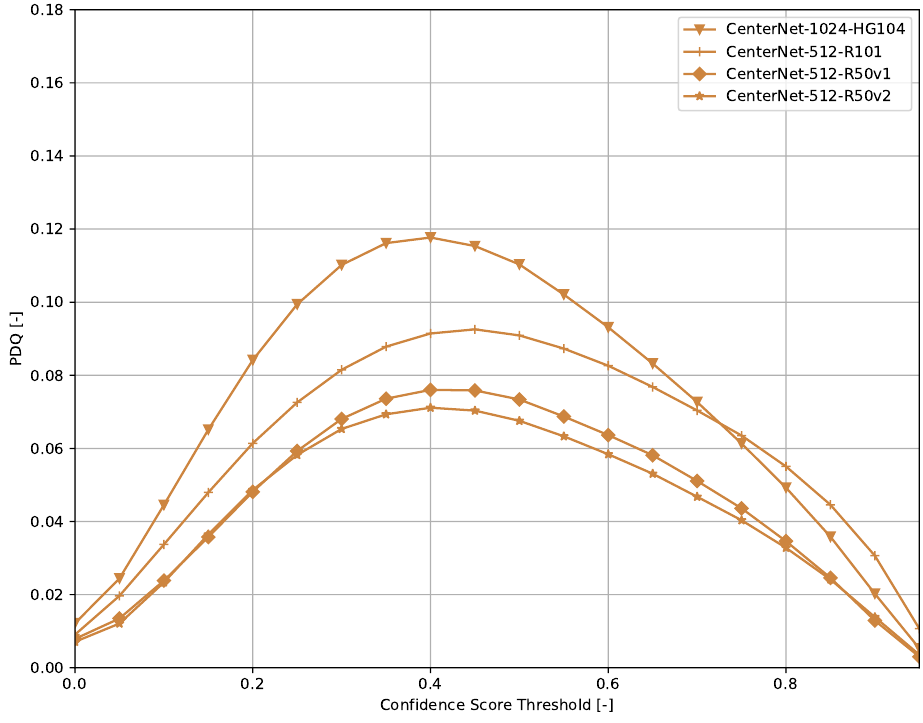
Figure 6. PDQ results of CenterNet on the COCO dataset.